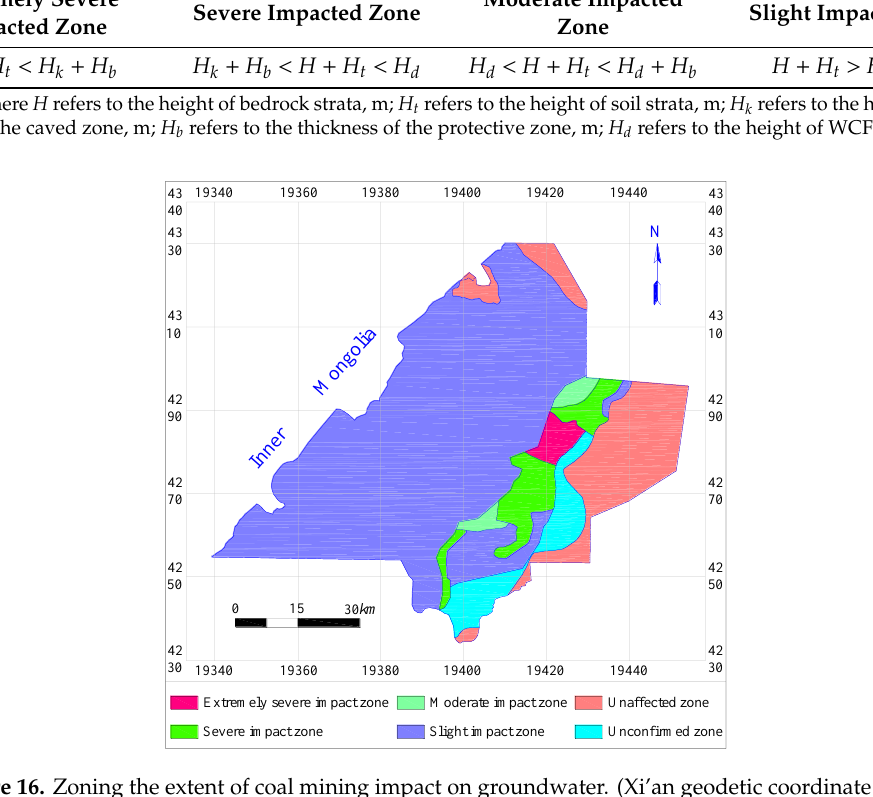
Figure 16. Zoning the extent of coal mining impact on groundwater. (Xi’an geodetic coordinate system 1980; in km).